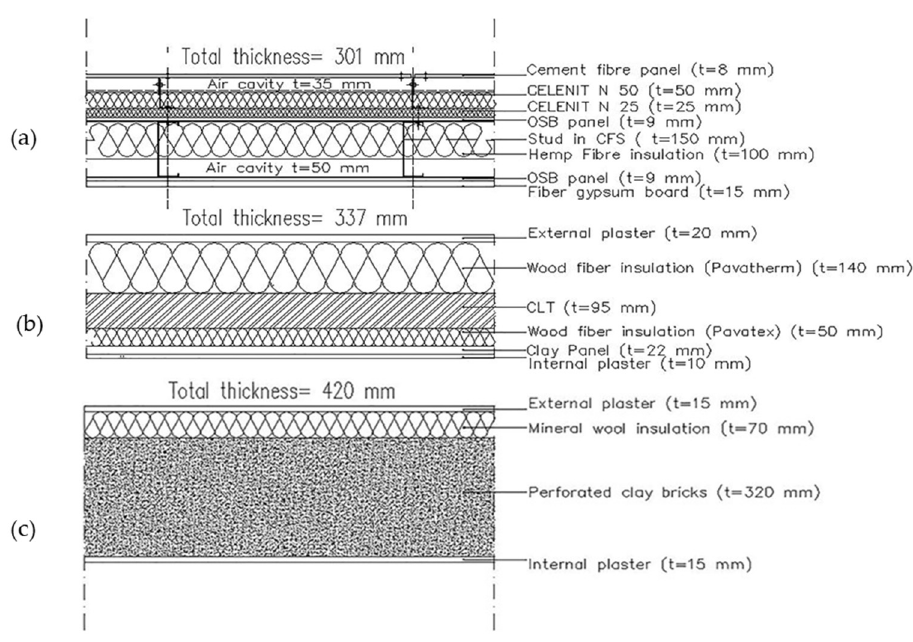
Figure 7. Workflow scheme.